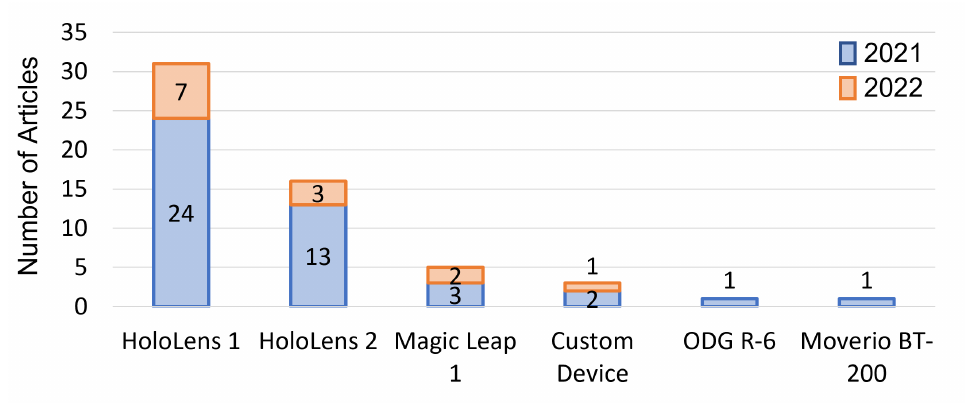
Figure 9. Distribution of the 57 articles included in the review based on the display device used.